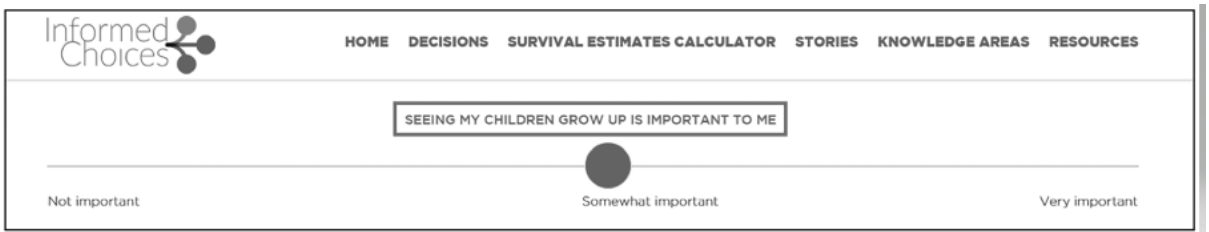
Figure 6. Pregnancy information as seen by study participants. Information about adoption and surrogacy has now been added to explain alternatives to pregnancy. The boxes indicate areas where text is being changed or emphasized to address user feedback. CF: cystic fibrosis.